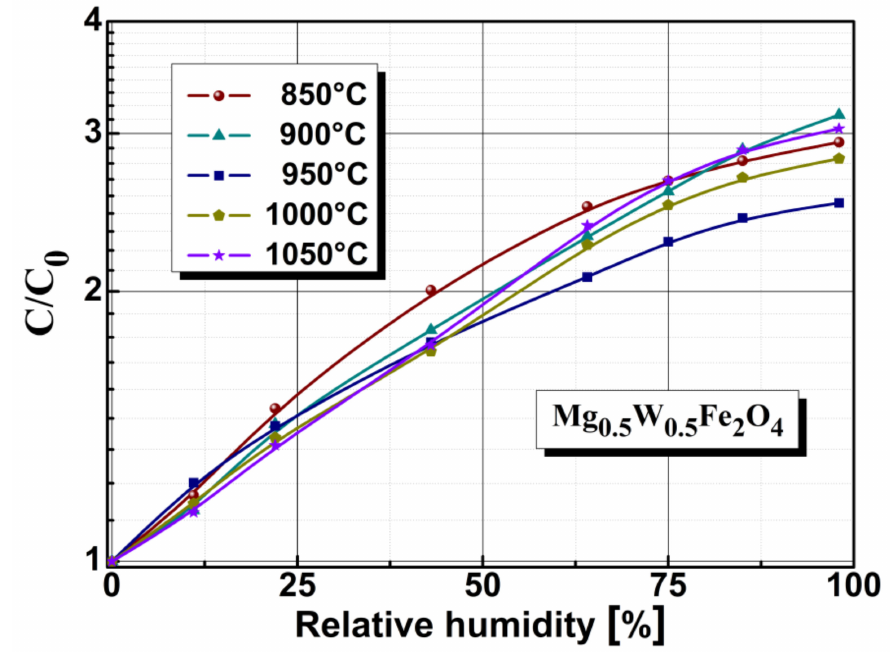
Figure 9. Electrical capacitance of sensors based on Mg 0.5 W 0.5 Fe 2 O 4 ferrite material annealed at various